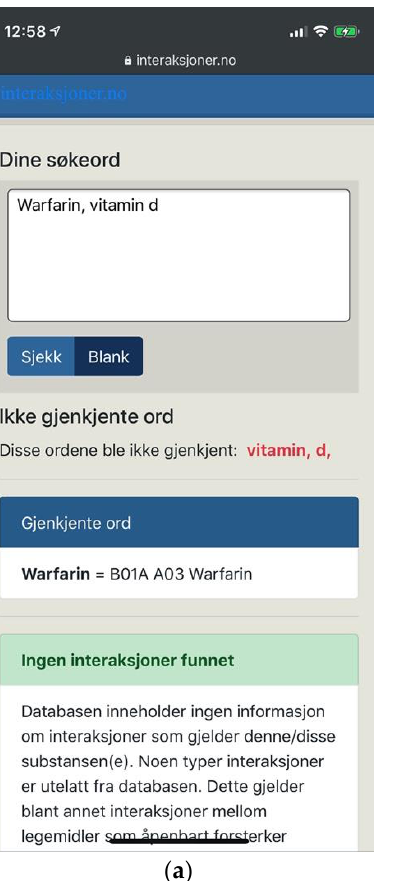
Figure 12. ( a ) Interaksjoner.no with an adaptive layout, a clear visual hierarchy and clear feedback; ( b ) Drug interaction details open on a new page in the same browser tab.